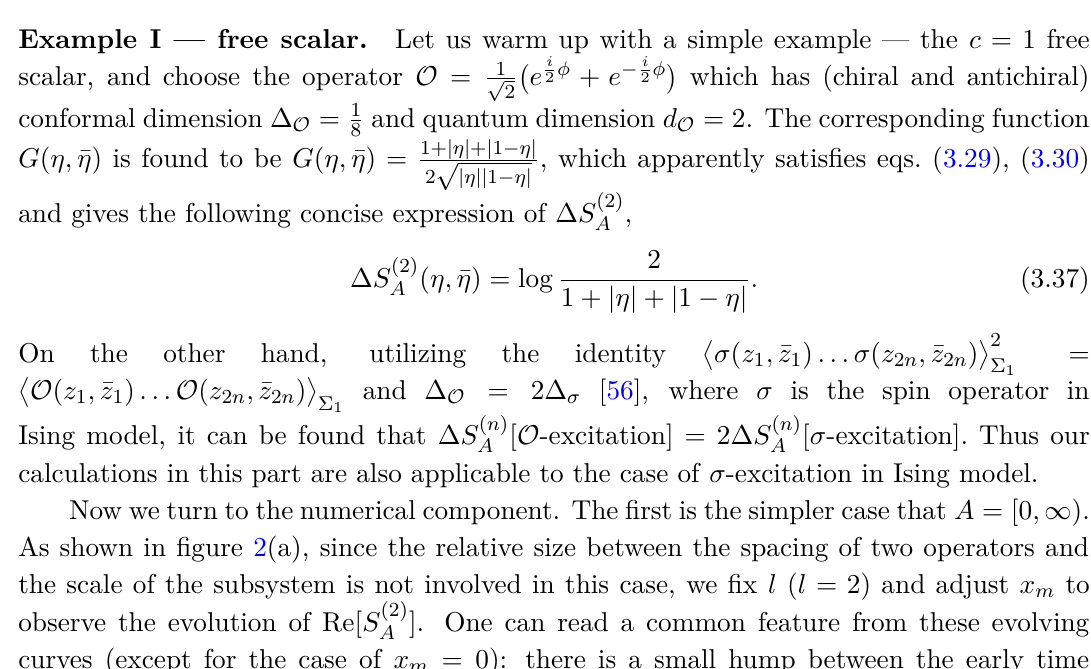
Figure 2. The real-time evolution of Re [∆ S (2) ] in c = 1 free scalar, where the insertion operator A is chosen to be 1 √ ( e iφ + e − iφ ) and the regulator (cid:15) = 10 − 5 . (a): A = [0 , ∞ ) , l = 2 ; (b): A = 2 [0 , 20] , l = 2 ; (c): A = [0 , 10] , x m = − 5 ; (d): A = [0 , 20] , x m = 10